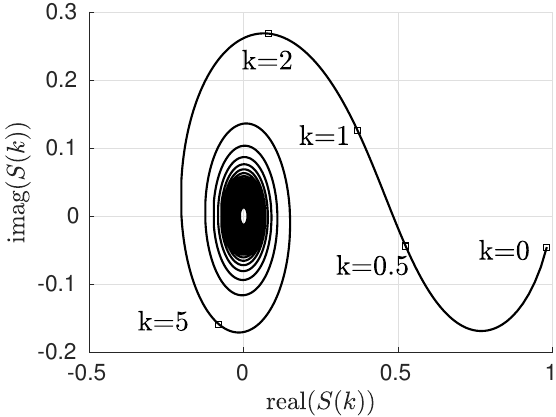
Figure 5. Sears function S ( k ) in the complex